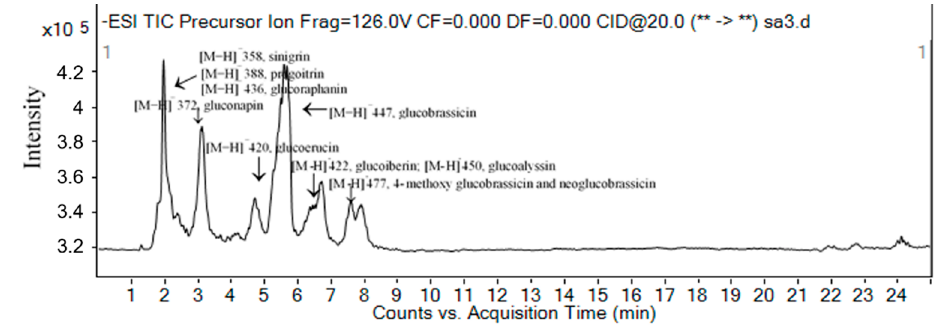
Figure 1. Total ion chromatogram (TIC): precursor ion scan of glucosinolates (molecular mass ions m/z [M − H] − ) in red cabbage.